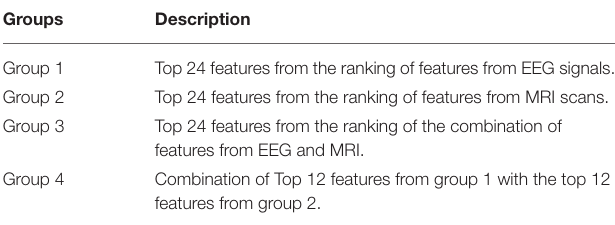
TABLE 3 | Top-feature grouping classes. Groups